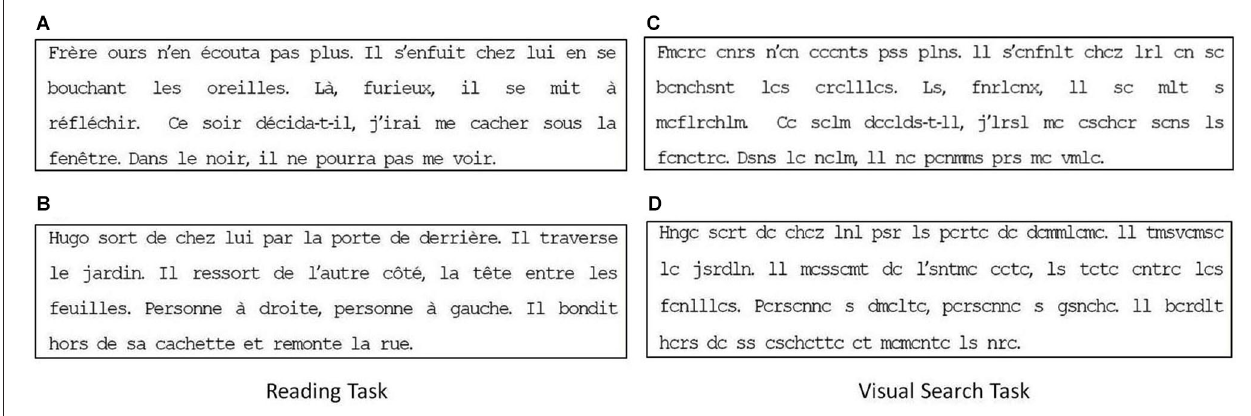
FIGURE 1 | Reading (A,B) and visual search (C,D) task respectively used for children with reading age of 8–9 and 10–13 years, respectively